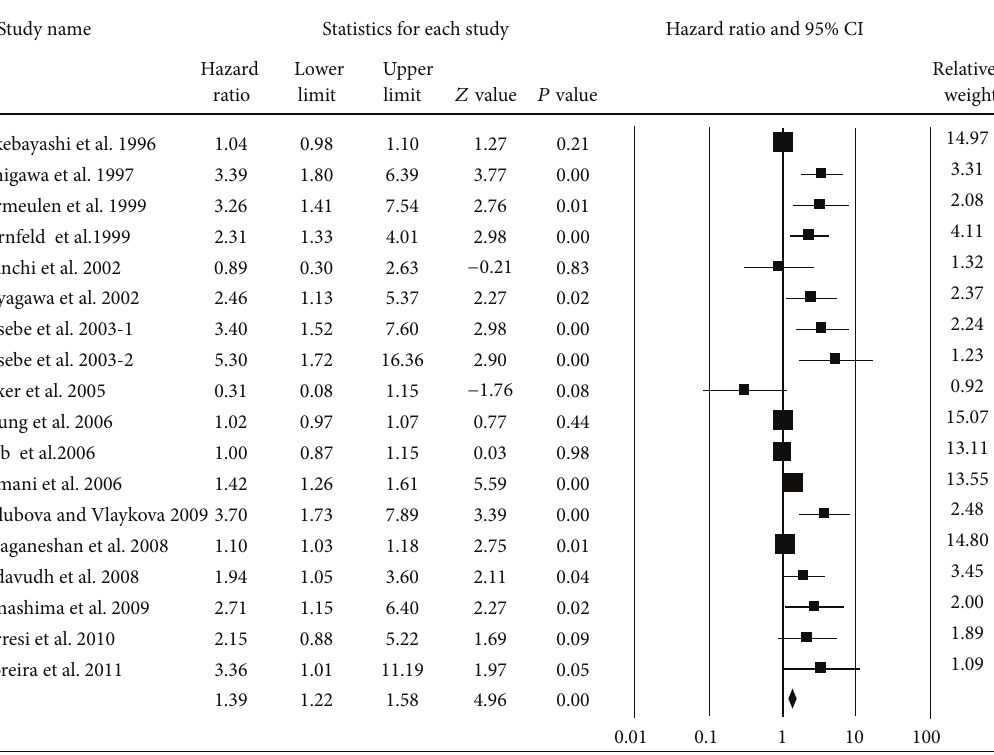
Figure 6: Forest plot for the association between MVD expression and overall survival of CRC.